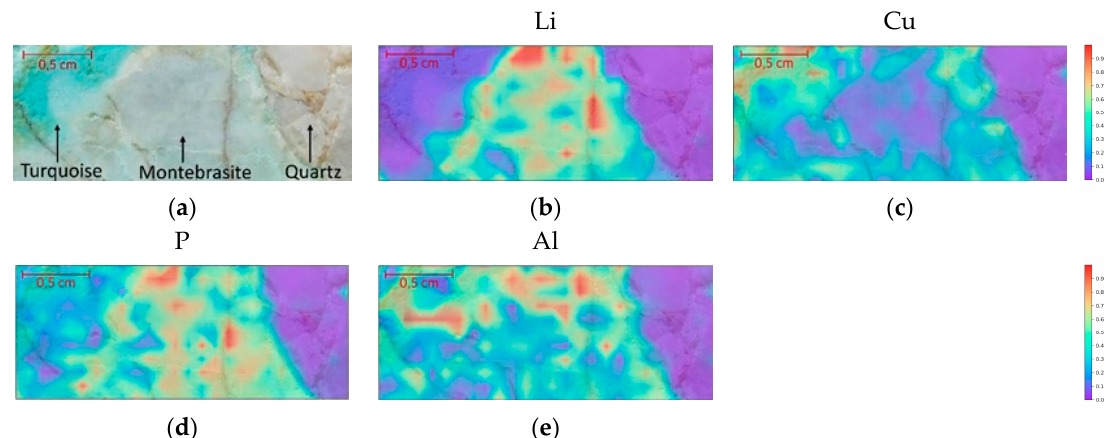
Figure 9. ( a ) LIBS mapping mineral distribution. ( b ) LIBS mapping overlaid the sample for Li (812.62 nm). ( c ) LIBS mapping overlaid the sample for Cu (327.37 nm). ( d ) LIBS mapping overlaid the sample for P (213.51 nm). ( e ) LIBS mapping overlaid the sample for Al (369.09 nm). Note: For ( b–e ), the color scale represents normalized intensity counts.